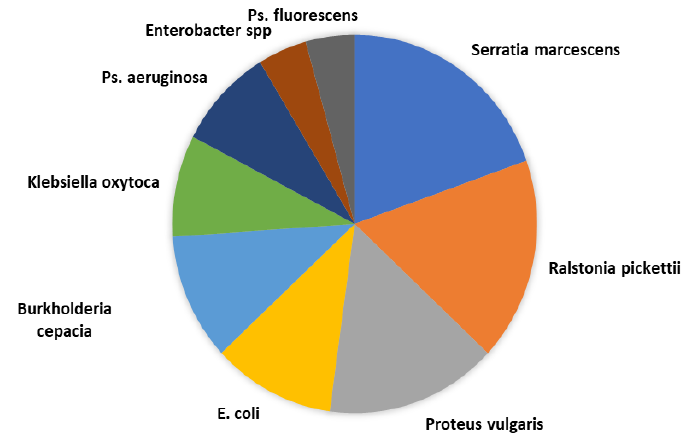
Figure 1. Proportion of gram-negative bacteria isolated and identified in doses of diluted semen (DS).